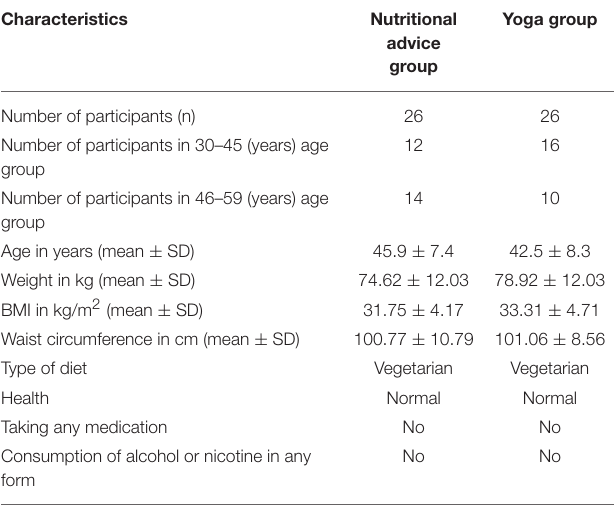
TABLE 1 | The baseline characteristics of the